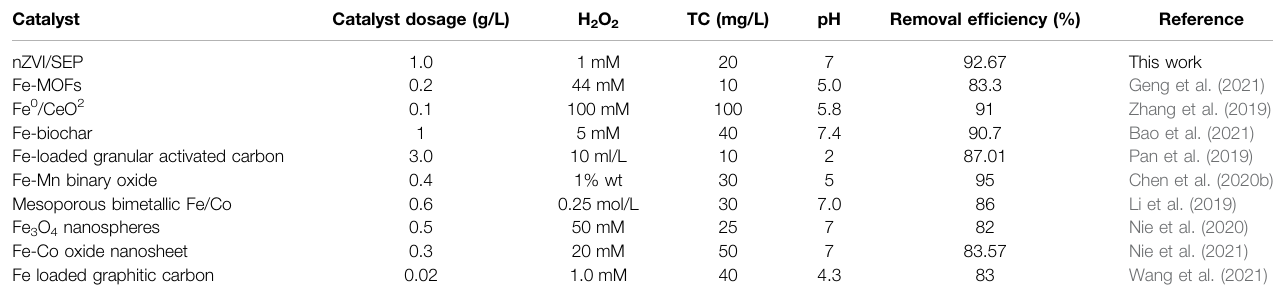
TABLE 2 | Comparison of removal ef fi ciency of various catalysts for tetracycline. Catalyst Removal ef fi ciency (%)